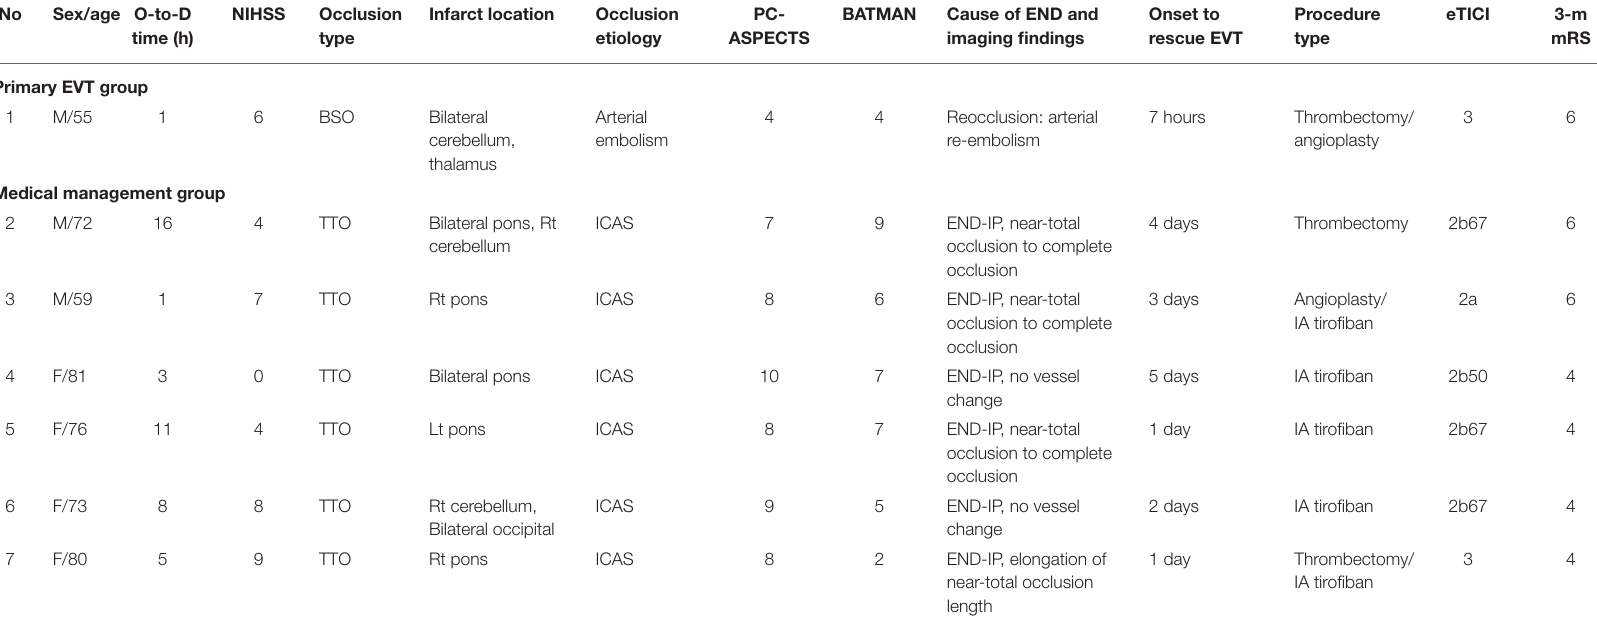
TABLE 4 | Clinical characteristics and outcome of patients who underwent rescue EVT